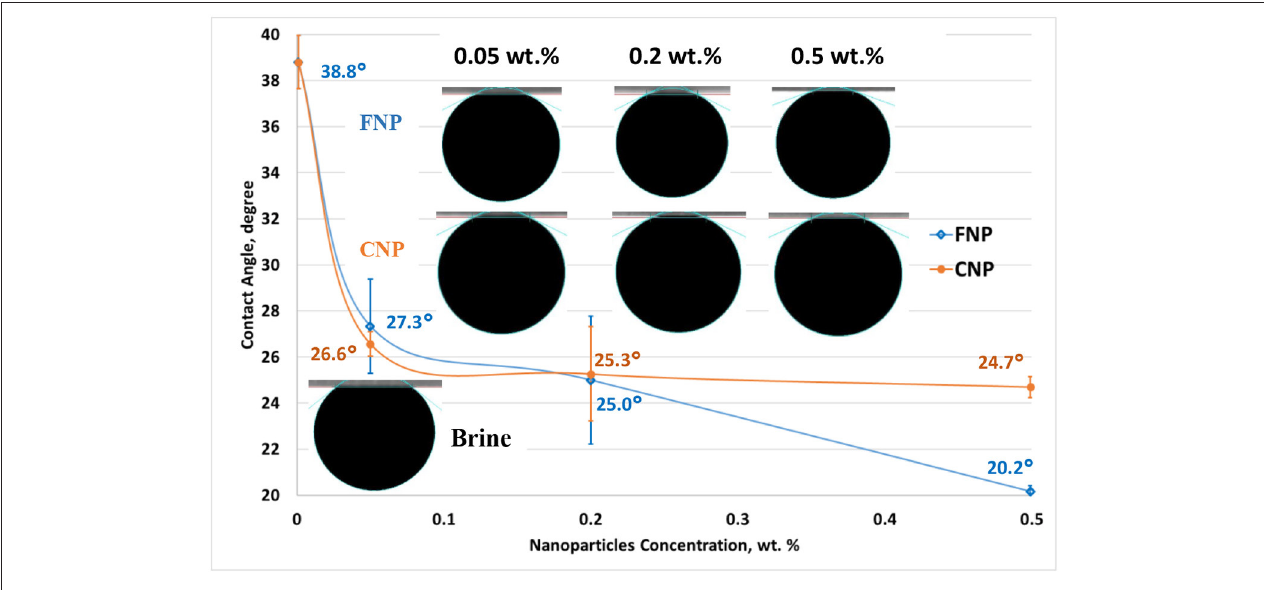
FIGURE 10 | Contact angle for a glass chip soaked in